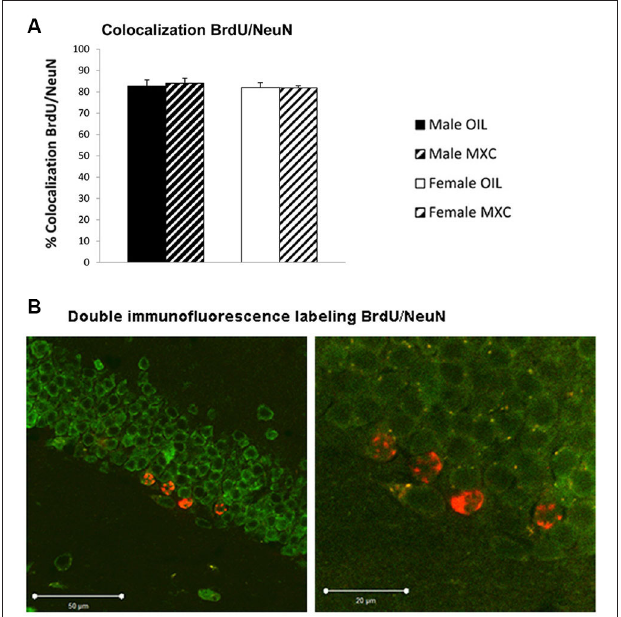
FIGURE 7 | Number and phenotyping of BrdU+ cells in the dentate gyrus of the hippocampus. (A) The percentage of BrdU+ cells that expressd NeuN did not significantly differ according groups. Data are expressed as mean ± SEM. (B) Representative confocal BrdU(red)/NeuN(green) double-labeled images in the DG of the hippocampus at low (left panel) and high (right panel)